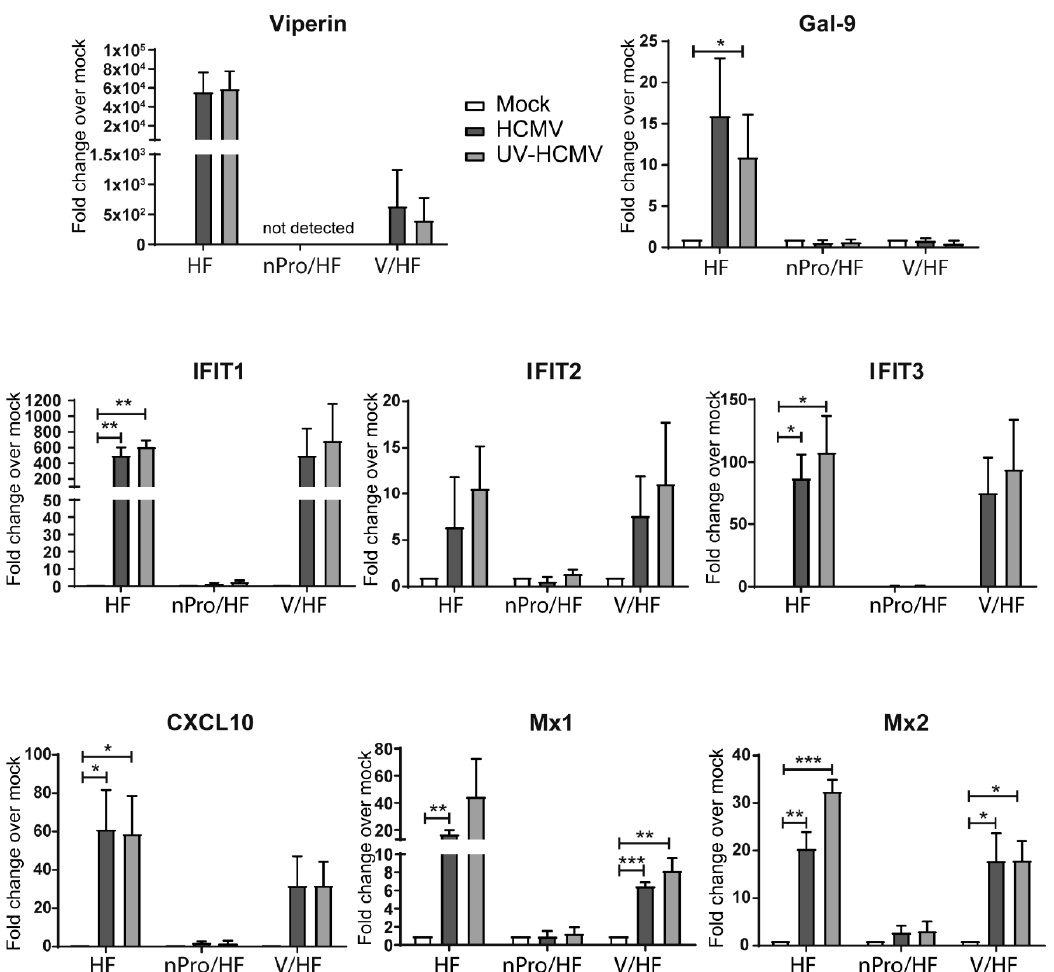
Figure 1. Regulation of interferon-stimulated gene (ISG) transcript levels following infection with intact or ultraviolet (UV)-irradiated human cytomegalovirus (HCMV) in cells with an abrogated interferon (IFN) response. Primary human foreskin fibroblasts (HFs), nPro expressing HFs (nPro/HFs) and V protein-expressing HFs (V/HFs) were infected in parallel with HCMV or UV-HCMV at an MOI of 3. 6 h.p.i. RNA was extracted, converted to cDNA and the relative levels of various ISG transcripts (normalised to the housekeeping gene GAPDH ) were calculated. Individual bars represent the average fold change in transcript level compared to the mock infection for each cell type (set to 1). Error bars indicate the SEM and statistical significance was determined using a Student’s two-tailed t -test, n = 3, * p < 0.05, ** p < 0.01, *** p < 0.001, **** p < 0.0001.